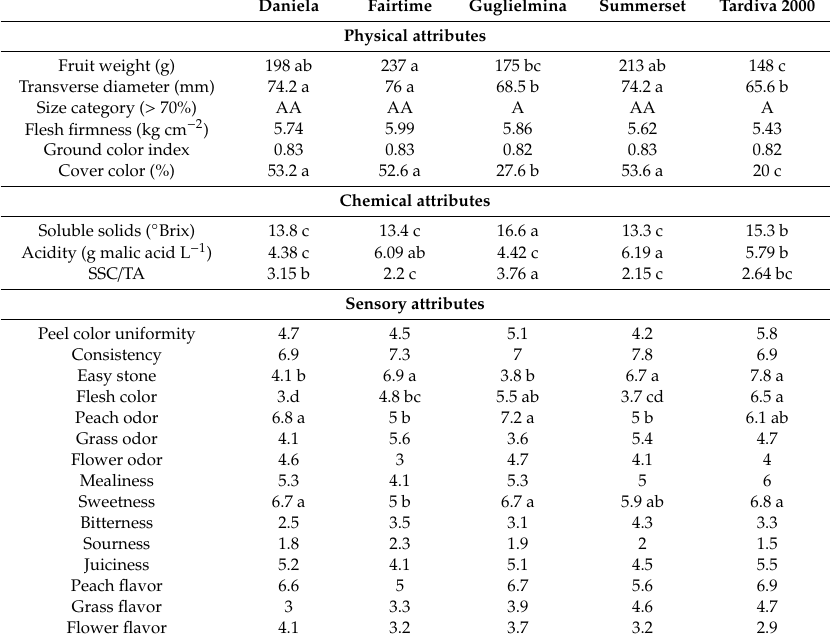
Table 2. Physical, chemical ( n = 30), and sensory ( n = 20) attributes for the five peach cultivars grown (500 trees / ha) near Riesi (37 ◦ 16 (cid:48) N and 330 m a.s.l.), in central–southern Sicily. Physical and chemical attribute assessments were done within a day from harvest. Di ff erent letters indicate significant di ff erences (Tukey’s test, p < 0.05) among cultivars and for each attribute. SSC: content of soluble solids, TA: titratable acidity.